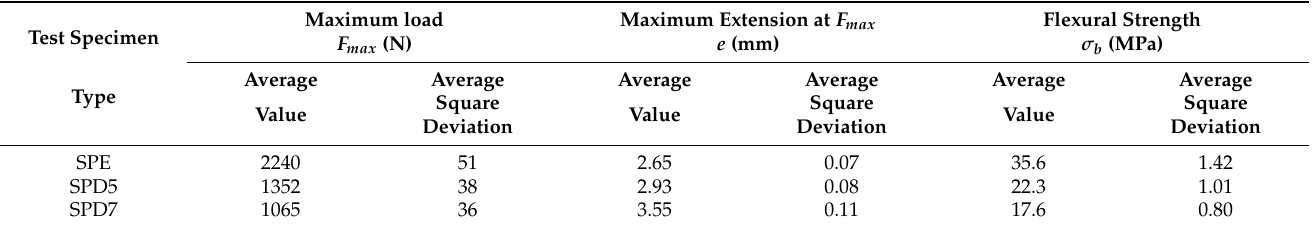
Table 5. Mean value and standard deviations for maximum load force and corresponding maximum extension for SPE, SPD5 and SPD7 test specimen